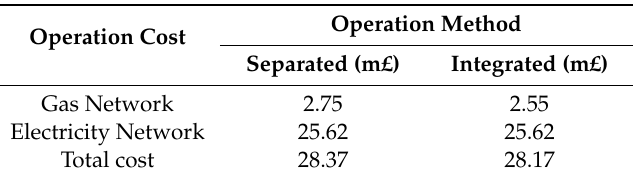
Table 7. Operation Cost of